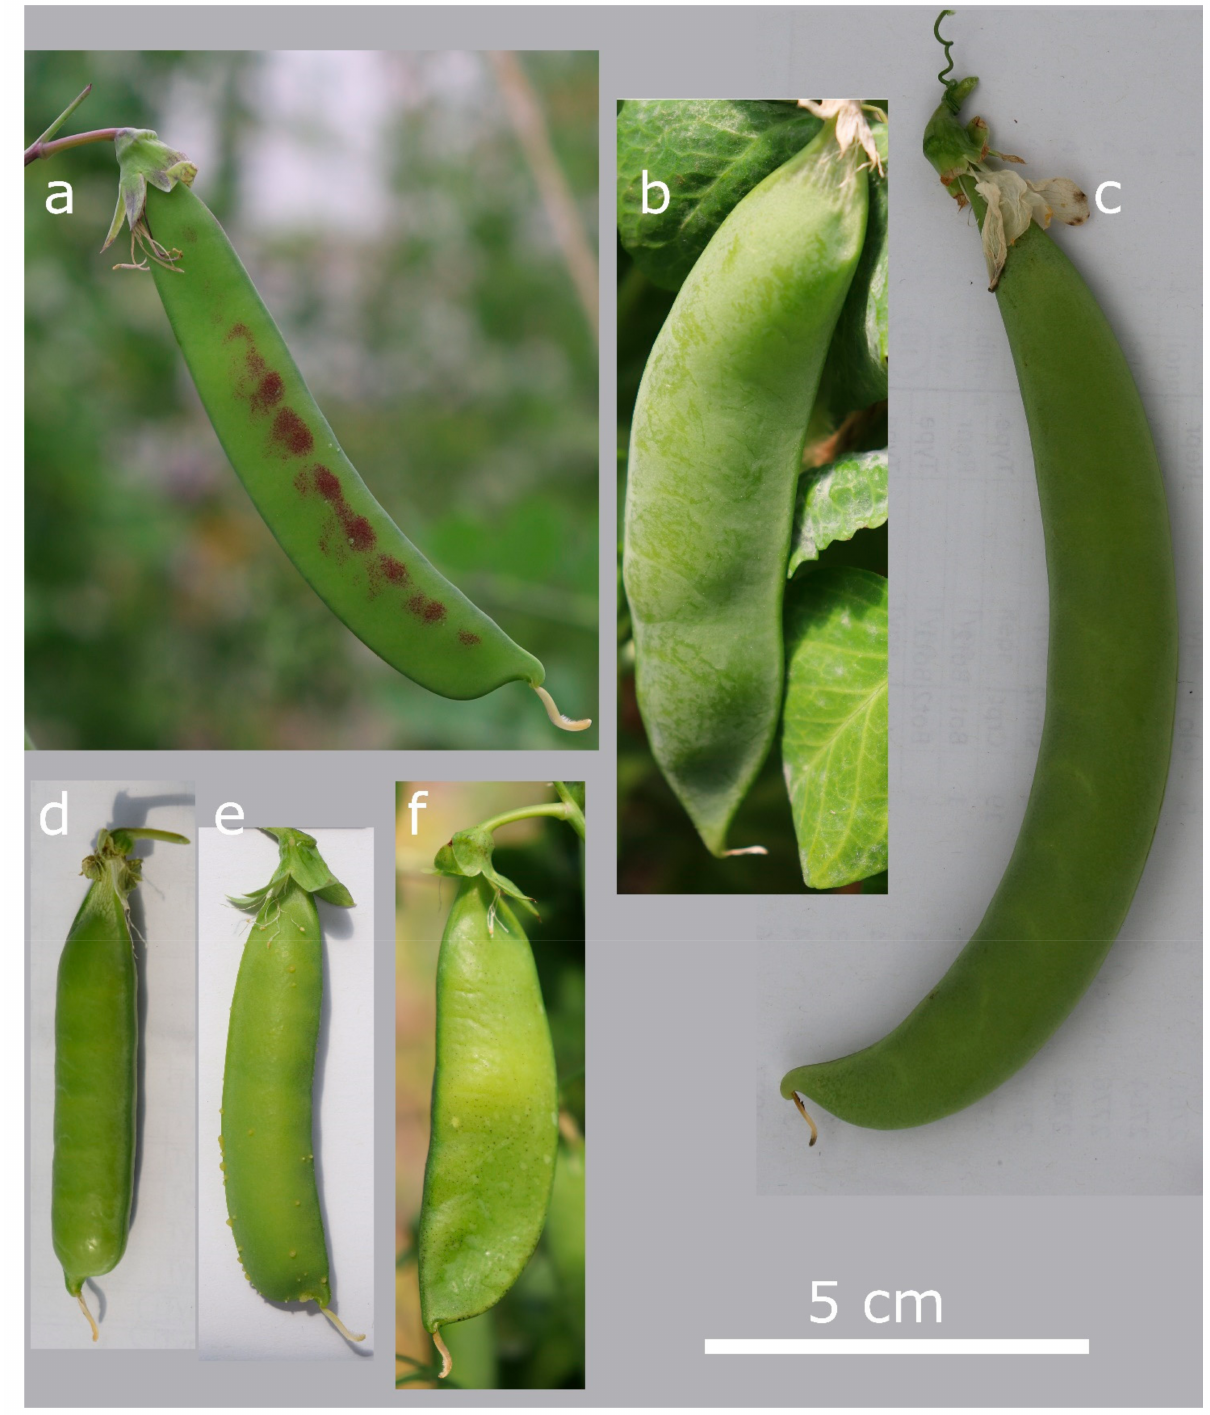
Figure 1. Phenotypes of pods illustrating different length: width ratios and pigmentation. ( a ) JI0064 P. elatius , showing purple spotting of the pod ( rup ) and occasional neoplasms ( Np ) with a length: width ratio consistent with te and a blunt tip ( Bt ). ( b ) JI0841 P. sativum with a convexly curved pod, consistent with co and a pointed tip ( bt ) ( c ) JI1245 P. sativum with a concavely curved pod, consistent with cp and a pointed tip ( bt ). ( d ) JI1473 P. sativum with wild type pod length: width ratio with a blunt tip ( Bt, Co, Cp, Te ). ( e ) JI0268 P. sativum from Crete with straight, blunt pods and exhibiting neoplasms ( Bt, Co, Cp, Np, Te ). ( f ) JI0007 P. sativum with unusually wide pods consistent with lt . Gene symbols are explained in Table 1 and Blixt 1972 [11] and the scale bar represents 5 cm for all panels see also Supplementary Table